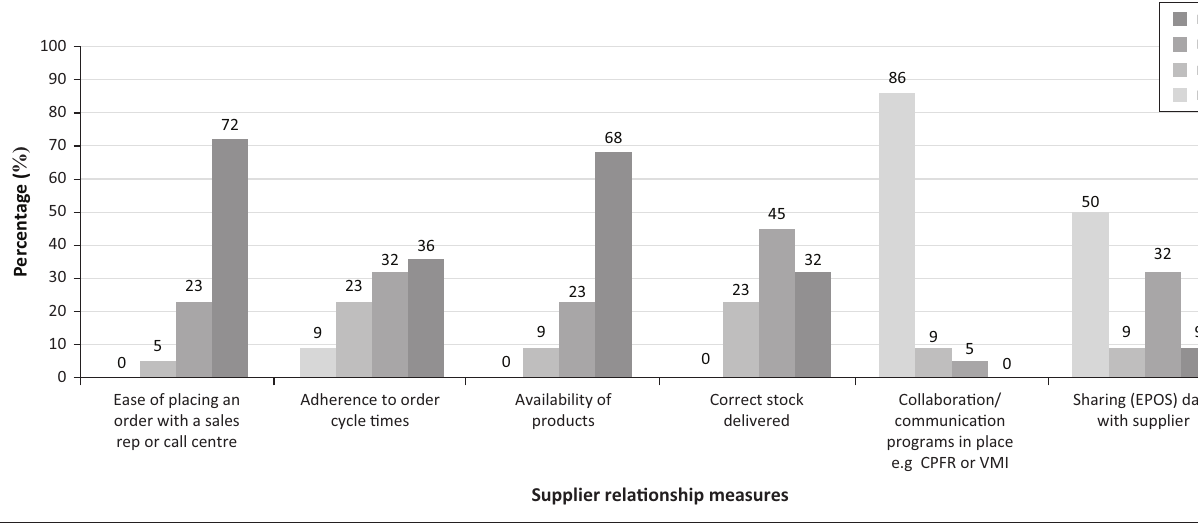
FIGURE 5: Supplier relationship (respondents’ rating in %